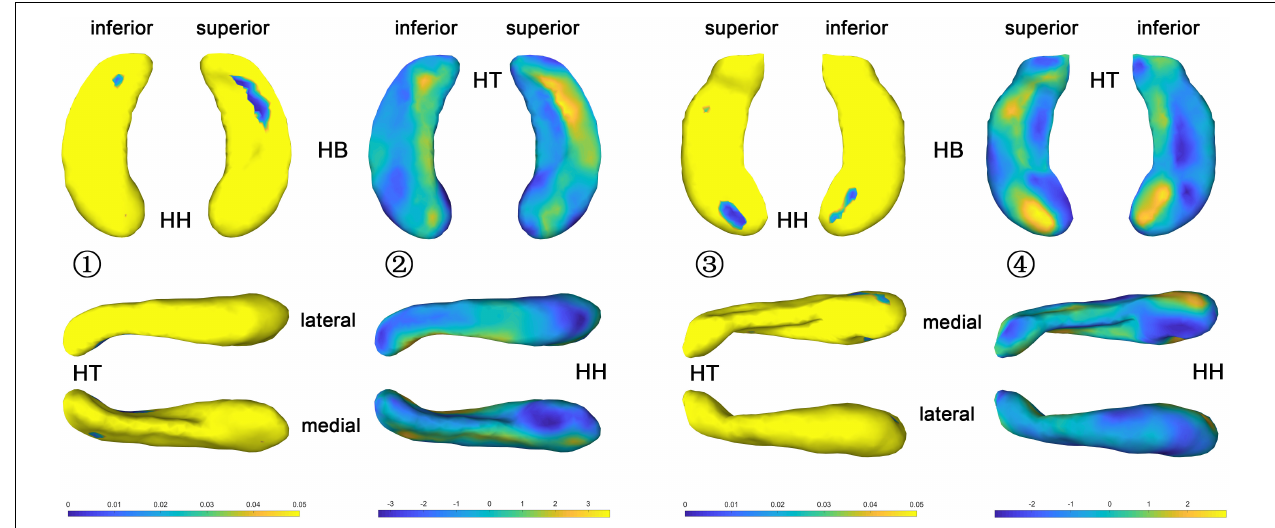
FIGURE 3 | P value and t value maps of congenital blind subjects compared with control group (uncorrected), from left to right columns are (1) p value map of left HF, (2) t value map of left HF, (3) p value map of right HF, and (4) t value map of right HF, respectively, p < 0.05 was considered as statistically significant. HH, hippocampal head; HB, hippocampal body; HT, hippocampal tail.